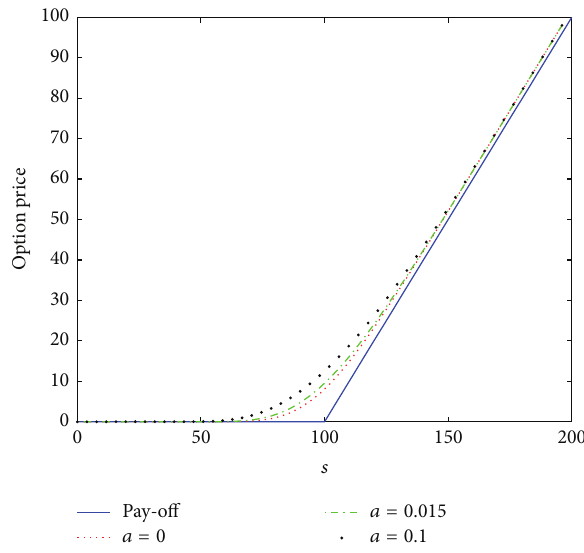
Figure1:OptionpricingofavanillaEuropeancalloptionforseveral values of parameter 𝑎 at maturity time 𝑇 = 1 year, where ℎ = 4 and Δ𝑡 = 0.0002 .